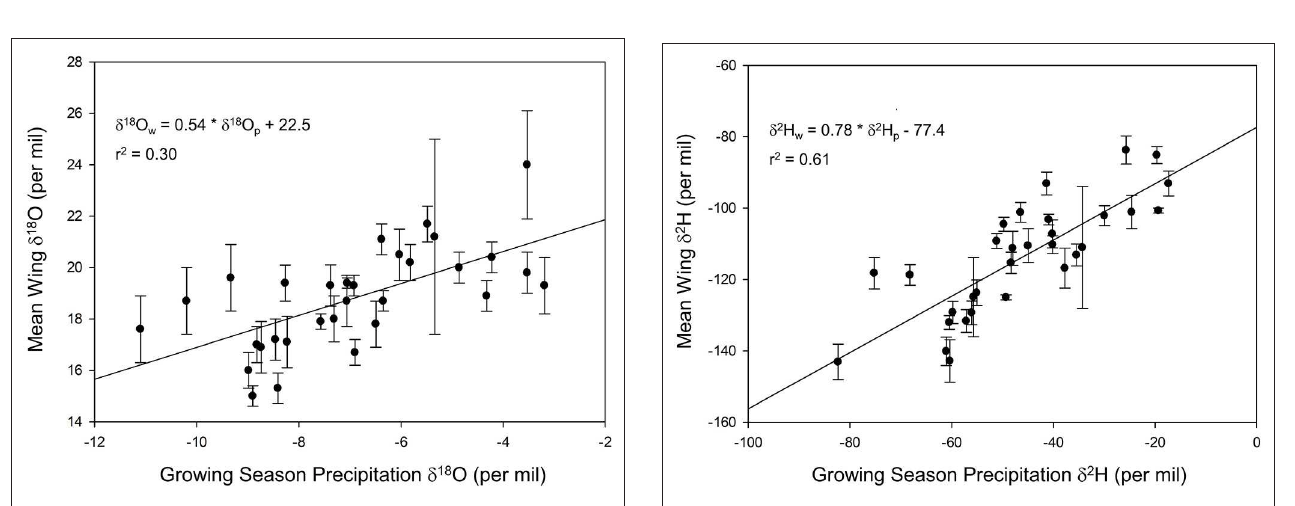
FIGURE 3 | Relationship between monarch δ 2 H w and amount-weighted mean growing-season average δ 2 H p (Bowen et al., 2005) for monarchs raised outdoors at 31 known sites ( Table 1 ) throughout their range in